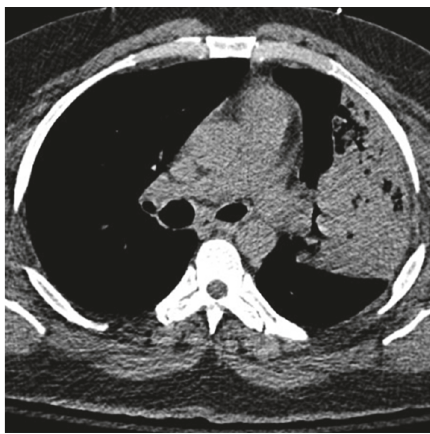
Figure 1: Chest X-ray with homogenous consolidation in the left lower lung field.